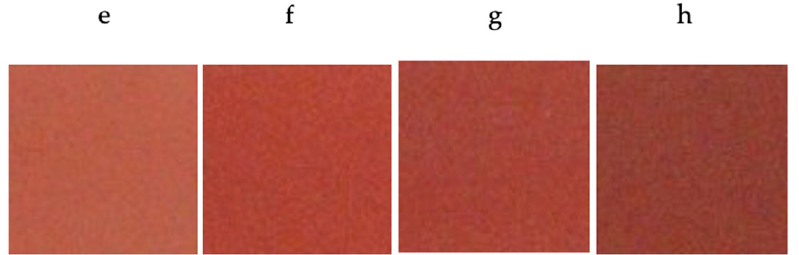
Figure 8. Color development of glazed tiles with fired pigment 1500 °C/6 h with 5% w / w CaF 2 addition. ( e ) YAl 0.99 Cr 0.01 O 3 ; ( f ) YAl 0.97 Cr 0.03 O 3 ; ( g ) YAl 0.95 Cr 0.05 O 3 ; ( h ) YAl 0.90 Cr 0.10 O 3 . Table 2. Chromatic coordinates values of glazed tiles in the Y 1 − x Cr x AlO 3 and YCr x Al 1 − x O 3 systems.